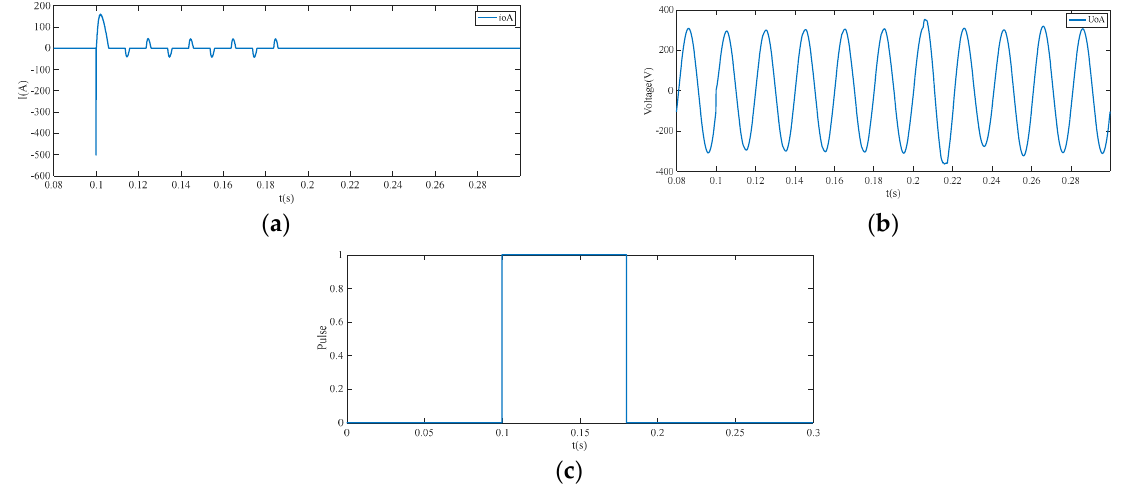
Figure 8. Simulation results of UPS with rectifier load using dynamic switching method ( a ) output current of phase A, ( b ) output voltage of phase A, ( c ) load pulse.